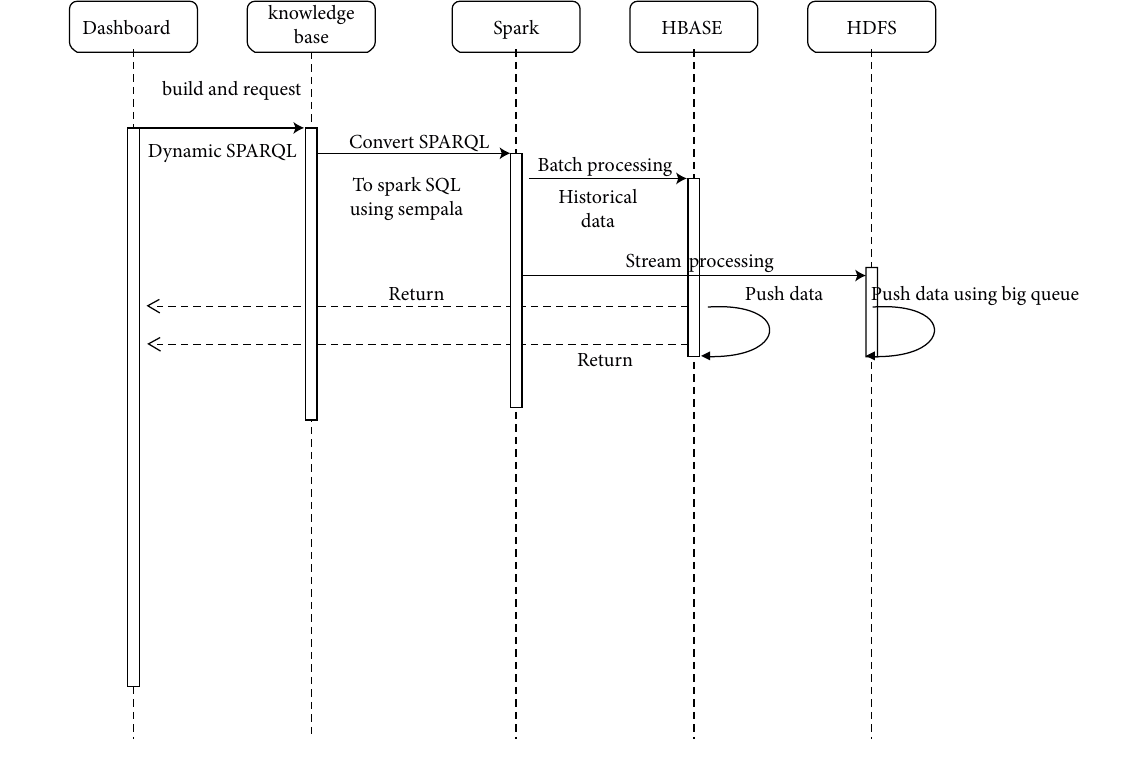
Figure 6: Data sequence diagram.